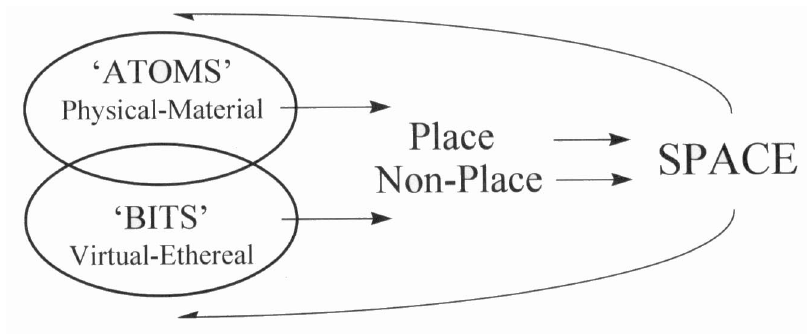
Figure 1. Geographic abstraction of physical, virtual and hybrid